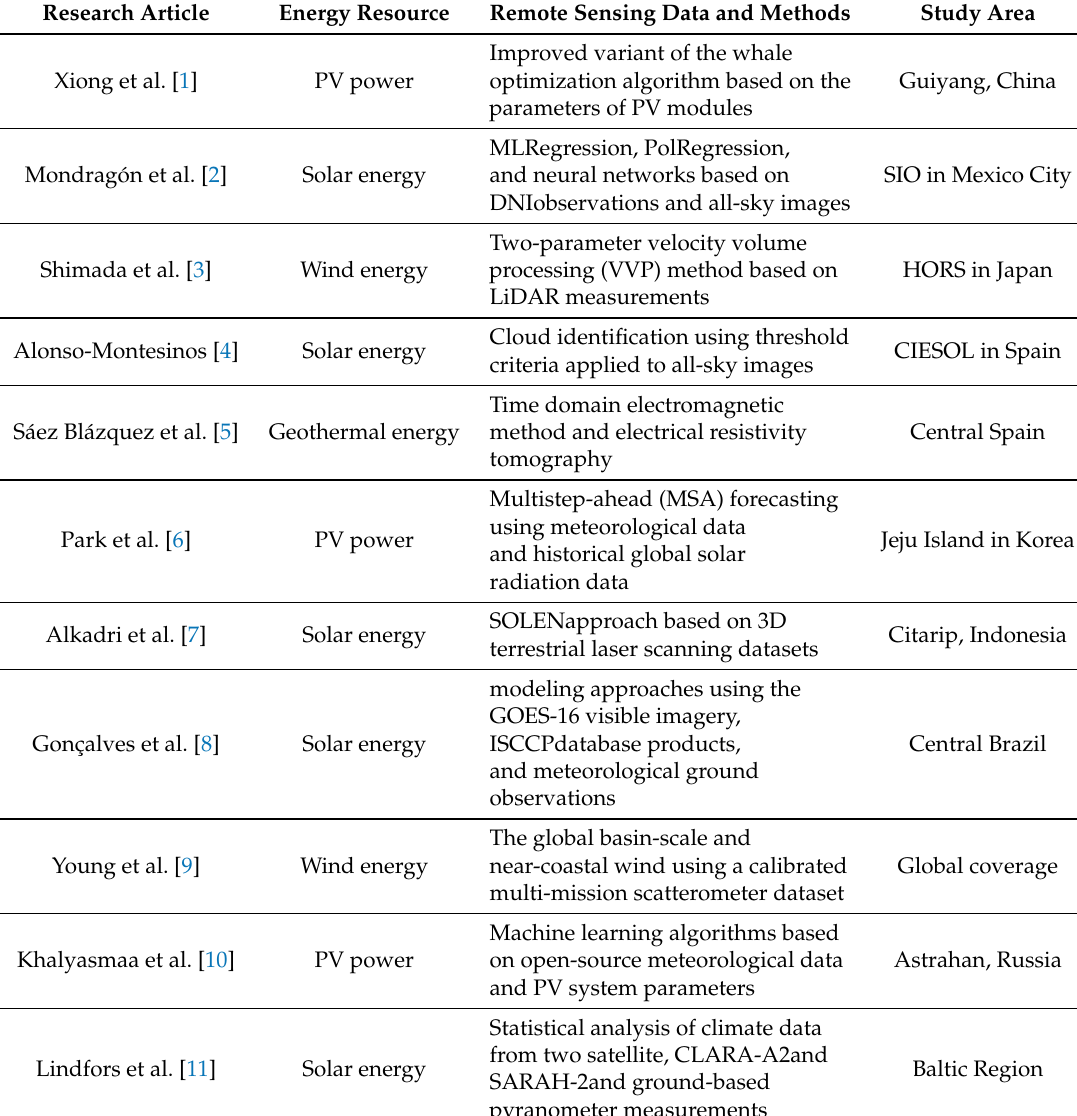
Table 1. Summary list of remote sensing data, methods, and study regions discussed in the eleven articles included in the Special Issue (sorted by the publication